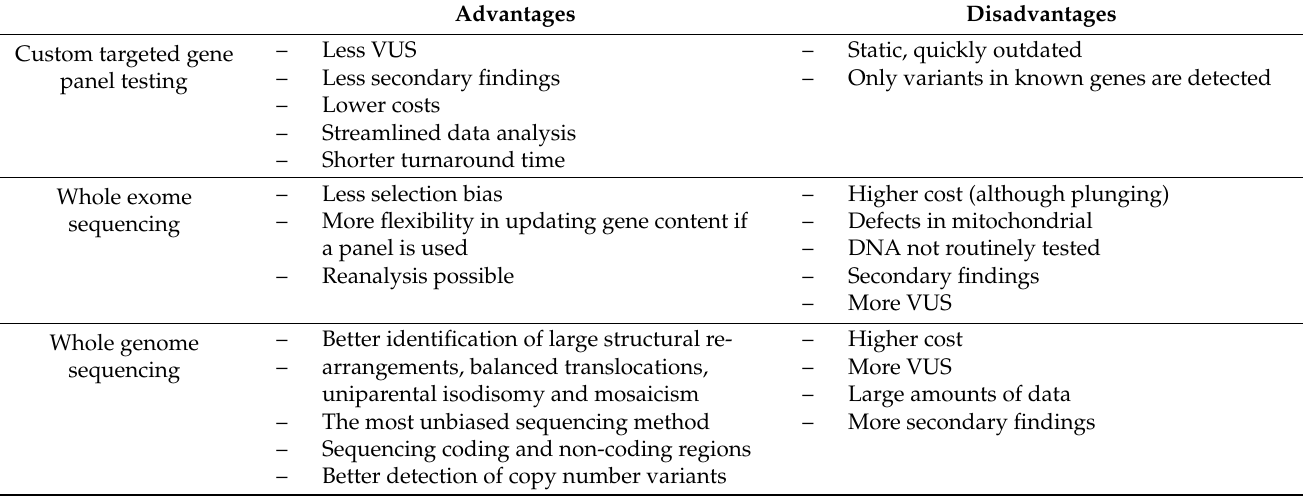
Table 3. Advantages and disadvantages of custom targeted gene panels, whole exome sequencing and whole genome sequencing (VUS = variants of uncertain